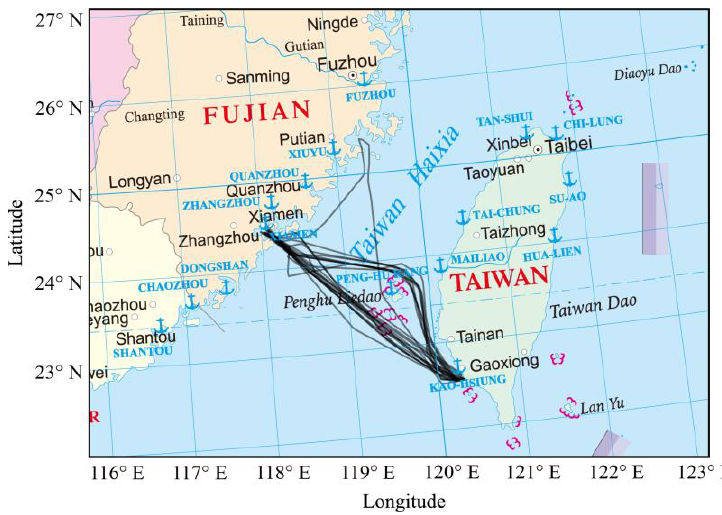
Figure 5. Ship trajectory map from Kaohsiung Port to Xiamen Port. Similarity Matrix Construction Based on Hausdorff